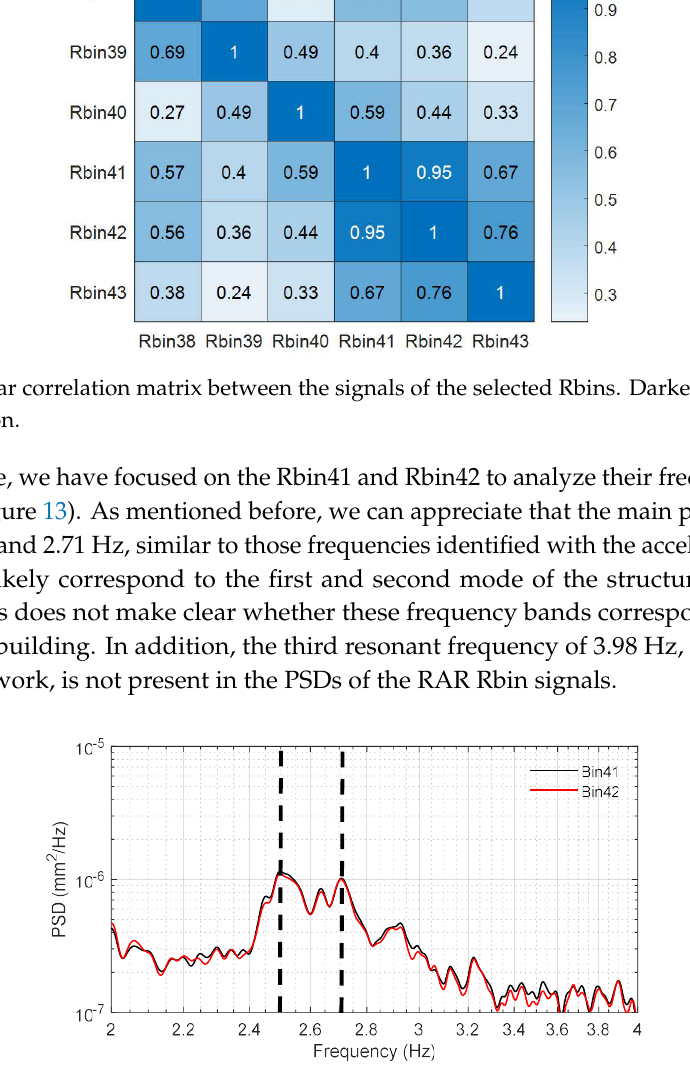
Figure 11. PSDs calculated by the Welch method for the signals recorded from Rbin38 to Rbin43. The dashed lines indicate the frequencies 2.49 Hz ( red ) and 2.79 Hz ( blue ), identified with the accelerometric data.